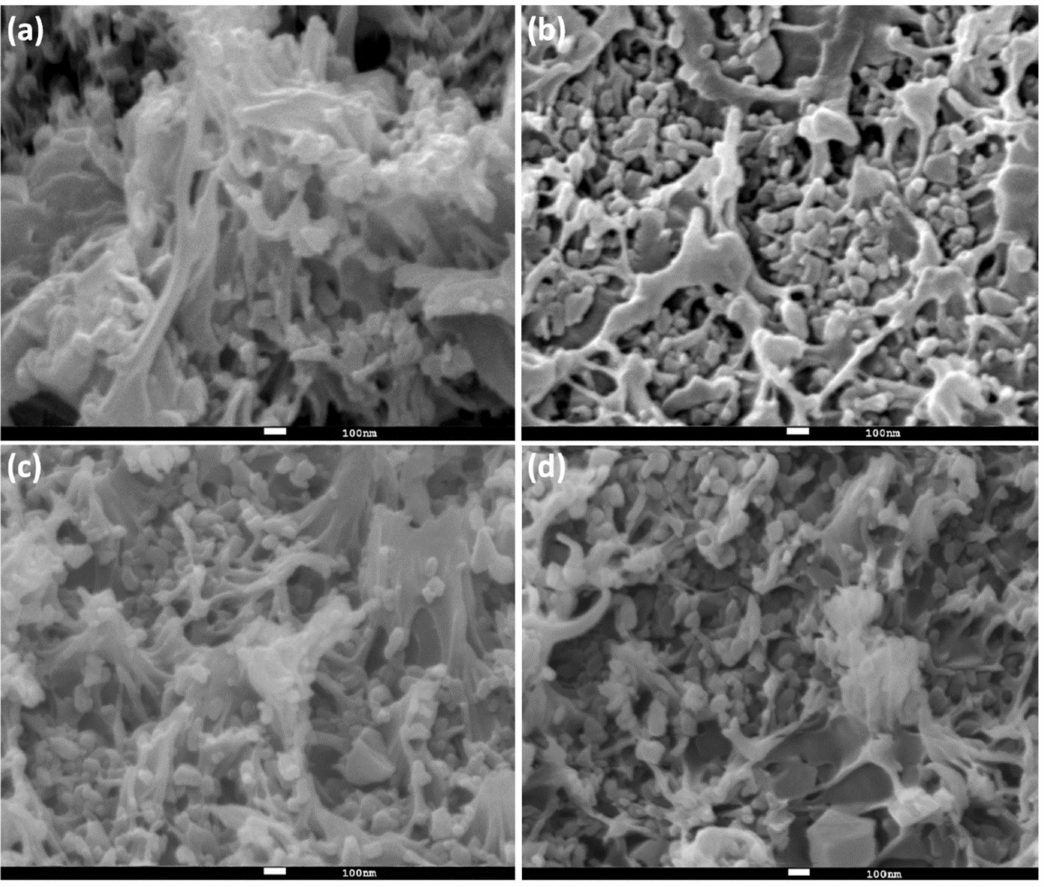
Figure 8. Cross-section SEM of ZIF-8@PES with di ff erent MOF mixing ratios ( a ) 10%, ( b ) 20%, ( c ) 30%, and ( d ) 40%.